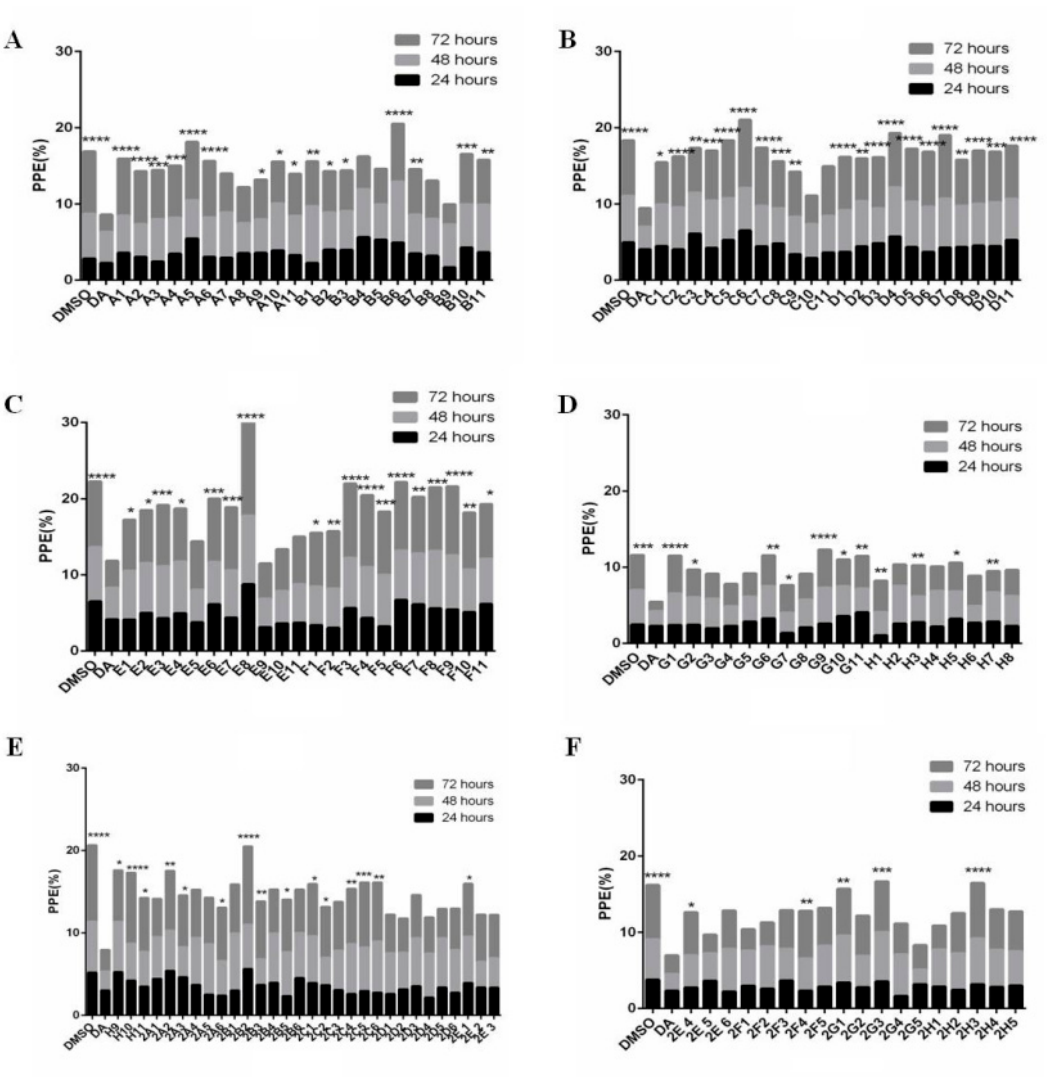
(Figure 1 and Table S2). For comparison with DMSO, the inhibitory e ff ects were calculated using the formula: ((parasitemia for DMSO minus parasitemia for natural products) / parasitemia for DMSO) × 100% (Figure 2 and Table S2). Significance analysis was carried out and the natural products with no significant di ff erence from DA were selected for rescreening. A comparison with DA and DMSO further selected 47 natural products with the code numbers of A7, A8, B4, B5, B8, B9, C10, E5, E9, E10, E11, G3, G4, G5, G8, H2, H4, H7, H8, 2A1, 2A4, 2A5, 2B1, 2B4, 2B6, 2C3, 2D1, 2D2, 2D3, 2D4, 2D5, 2D6, 2E2, 2E3, 2E5, 2E6, 2F1, 2F2, 2F3, 2F5, 2G2, 2G4, 2G5, 2H1, 2H2, 2H4, and 2H5. The full names of the 47 natural products are detailed in Table S1.